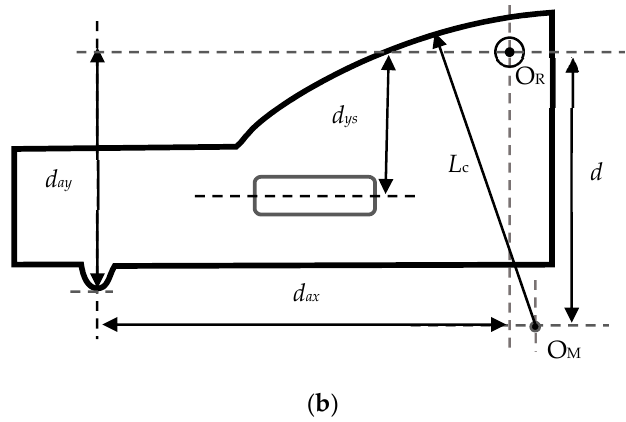
Figure 2. Schematic of the VCBS mechanism. ( a ) Schematic; ( b ) swingarm geometry. Due to the cam profile, the input force F acting on the roller C generates a force component to move roller C along the cam surface to a balance position. Therefore, the position of F ’s acting point can be varied to change the force distribution ratio R f . To provide the required reacting forces for the movement of roller C, rollers H and R are confined to slide on their respective guides on the mechanism’s shell. A nonlinear returning spring mounted in the slot of the swingarm provides a balancing force against the movement of roller C. In this mechanism, the cam profile and the returning spring’s stiffness are the critical parameters for the braking forces distribution design.